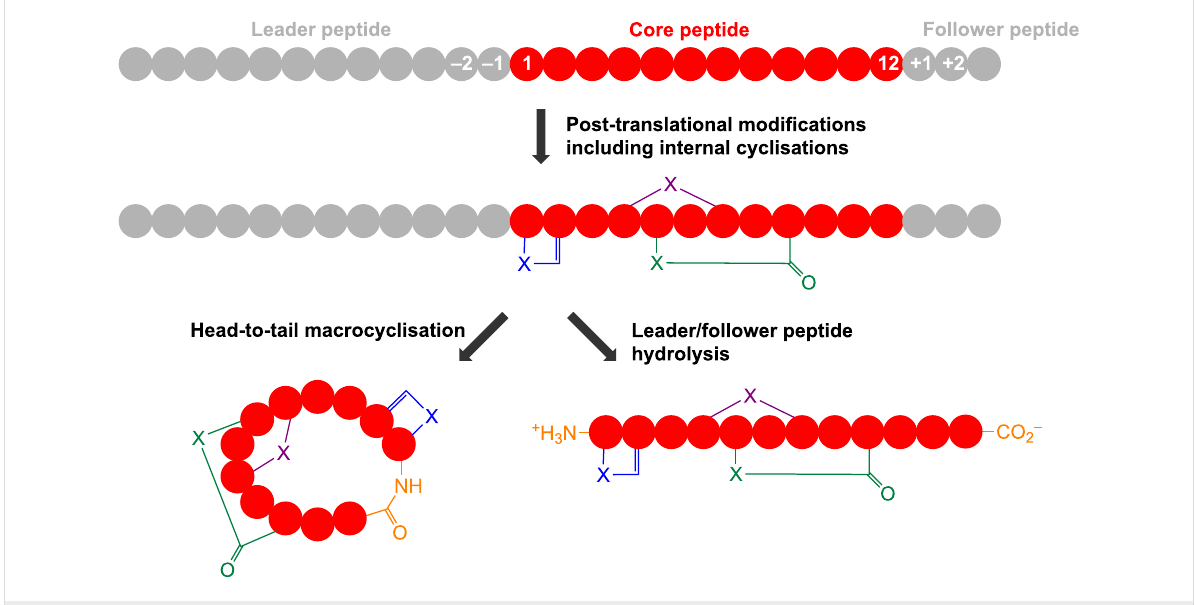
Figure 1: Schematic of RiPP biosynthesis. Thiazole/oxazole formation is represented by the blue heterocycle (X = S, O), lanthionine formation is represented by the purple cross-link (X = S) and macrolactam (X = N) or macrolactone (X = O) formation is represented by the green cyclisation.